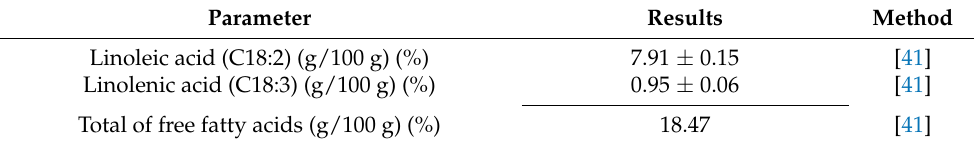
Table 1. Cont. Parameter